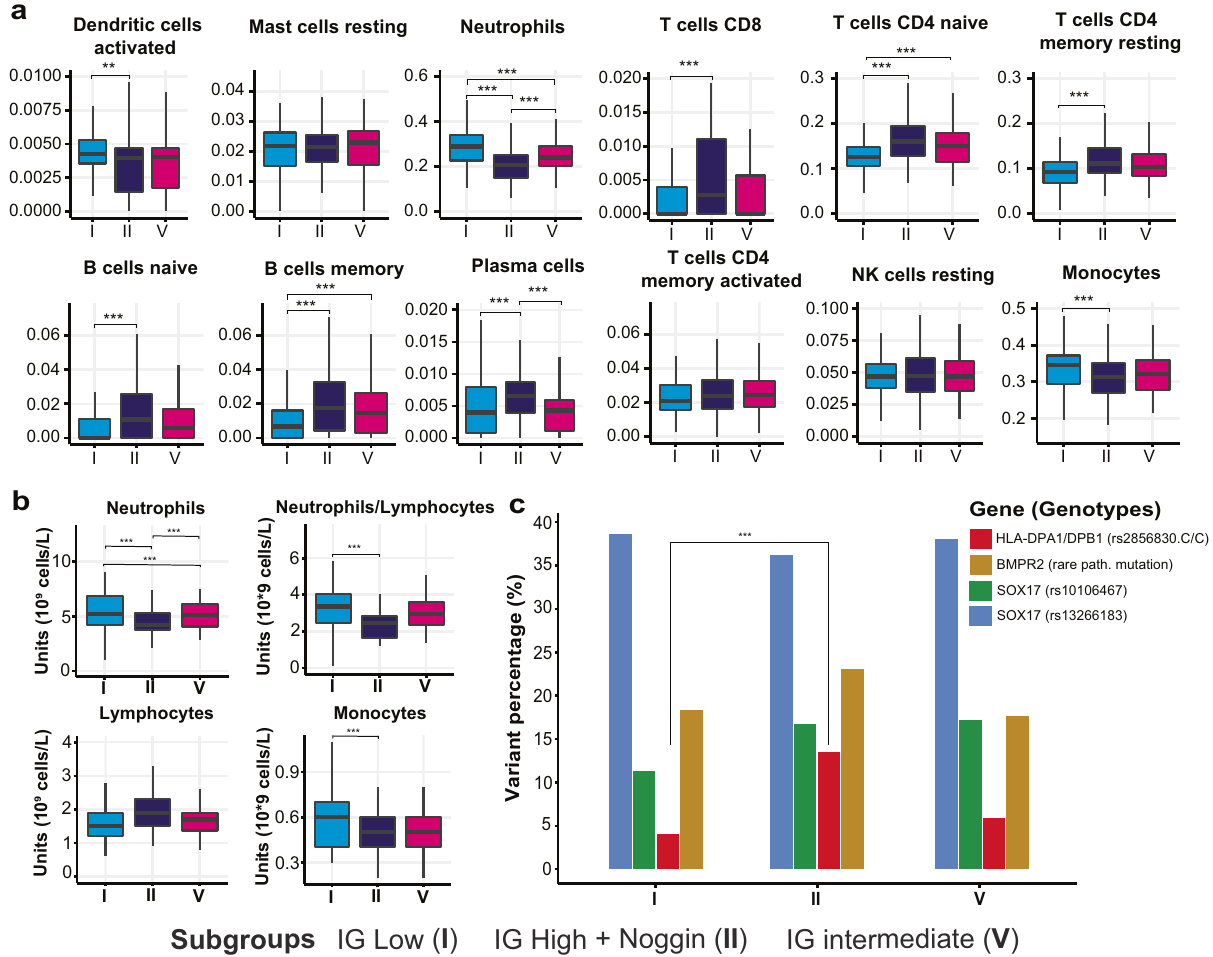
Fig. 4 Immunity cell composition across PAH transcriptomic subgroups. a CIBERSORT estimation of relative cell abundance in patients of subgroups I ( n = 129), II ( n = 112) and V ( n = 89) using two-sided test and Bonferroni adjusted mean difference signi fi cance notation with p values: = 0.011, = 4.4 × 10 − 11 , = 2.0 × 10 − 3 , p = 1.7 × 10 − 3 , = 4.8 × 10 − 5 , pI-II(Dendritic cells activated) pI-II(Neutrophils) pI-V(Neutrophils) II-V(Neutrophils) pI-II(T cells CD8) = 1.9 × 10 − 8 , = 3.8 × 10 − 3 , = 2.3 × 10 − 5 , = 2 × 10 − 5 , pI-II(T cells CD4 naive) pI-V(T cells CD4 naive) pI-II(T cells CD4 memory resting) pI-II(B cells naive) = 2.5 × 10 − 6 , = 3.9 × 10 − 3 , = 6.4 × 10 − 4 , p = 6.5 × 10 − 5 and = 0.0053. Vertical pI-II(B cells memory) pI-V(B cells memory) pI-II(Plasma cells) II-V(Plasma cells) pI-II(Monocytes) centre line represents the median, top and bottom bounds of the box represent the fi rst and third quartile, while the tips of the whiskers represent min and max values. b Whole-blood cell counts across subgroups I ( n = 129), II ( n = 112) and V ( n = 89) using two-sided test and Bonferroni adjusted mean difference signi fi cance notation. pI-II (Neutrophils) = 7.2 × 10 − 12 , pI-V (Neutrophils) = 8.0 × 10 − 4 , p II-V (Neutrophils) = 4.4 × 10 − 4 , pI-II (Neutrophils/Lymphocytes) = 0.0061 and pI-II (monocytes) = 0.0076. Vertical centre line represents the median, top and bottom bounds of the box represent the fi rst and third quartile, while the tips of the whiskers represent min and max values. c Proportion of patients in each subgroup with DNA variants in HLA-DPA1/DPB1 (rs2856830), SOX17 (rs10106467 and rs13266183, homozygous and heterozygous), BMPR2 (rare pathogenic variant). Notably, p I-II (HLA-DPA1/DPB1) = 0.009. Generated using a two-sample test for equality of proportions with continuity correction. * P value ≤ 0.05, ** p value ≤ 0.01, *** p value ≤